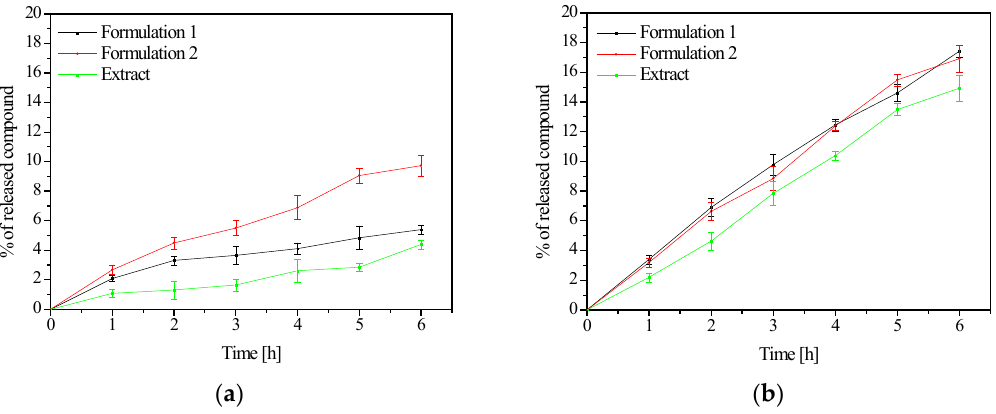
Figure 4. Released profiles of aloin A ( a ) and aloenin A ( b ) from formulation 1 and 2. It is worth adding that, despite the low level of aloenin A release, the prepared formulations 1 and 2 showed comparable activity to the starting lyophilized aqueous gel. In the case of antioxidant activity (DPPH assay), IC50 was 34.24 ± 0.71 and 33.45 ± 1.49 mg/mL for formulation 1 and 2, respectively. Inhibition of hyaluronidase was 5.80 ± 1.12% and 6.02 ± 0.59%, whereas the inhibition of tyrosinase was 11.23 ± 2.32% and 12.56 ± 1.54%, for formulation 1 and 2, respectively. The obtained results do not differ statistically from those obtained for the starting lyophilized aqueous gel, which confirms the lack of influence of the hydrogel base on the activity of the finished formulation.